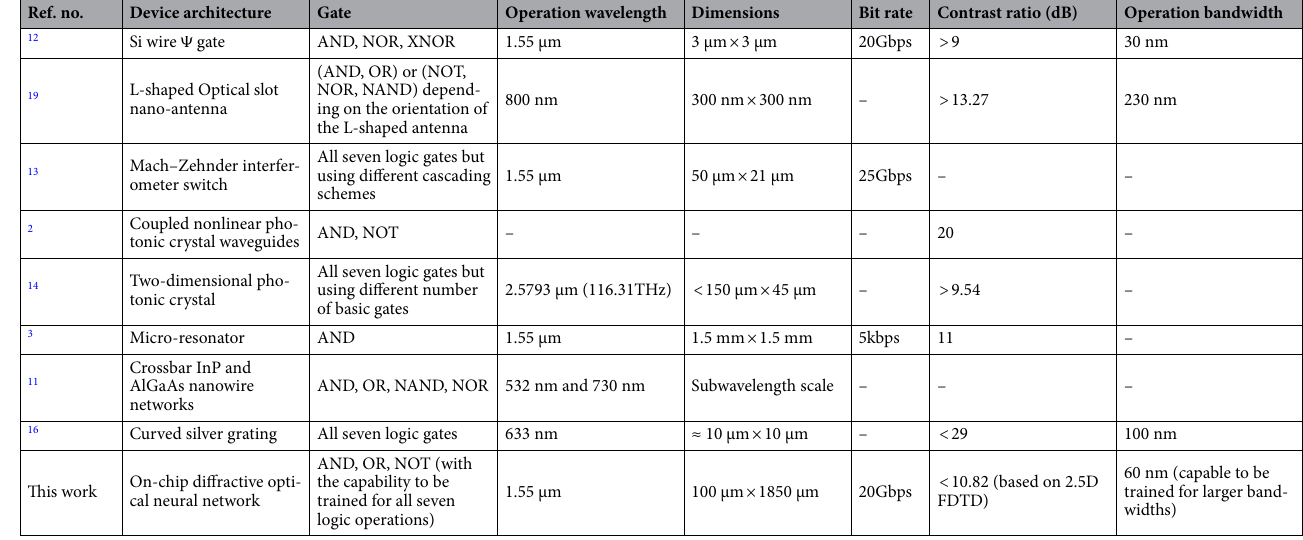
Table 4. Comparison between our design and some of the state-of-the-art optical logic